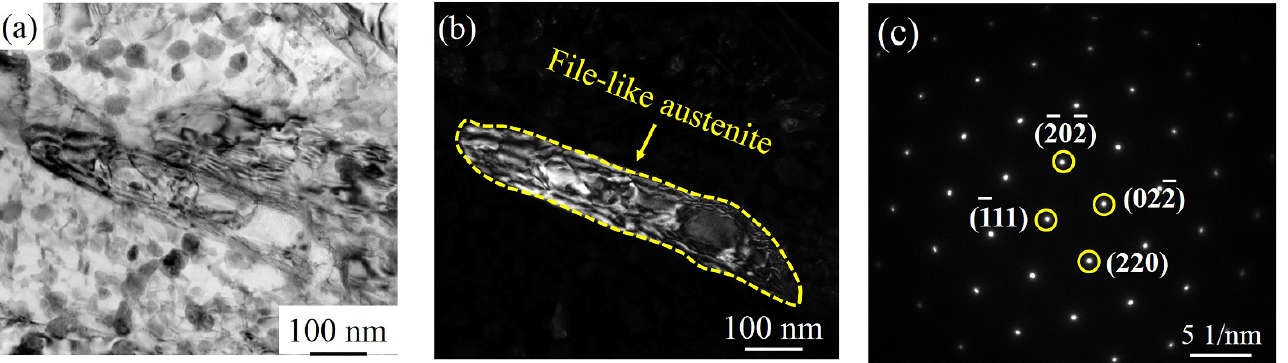
Figure 16. Morphology of austenite in 600A-4: ( a ) bright-field image, ( b ) dark-field image, and ( c ) diffraction spots of austenite along with the calibration results.